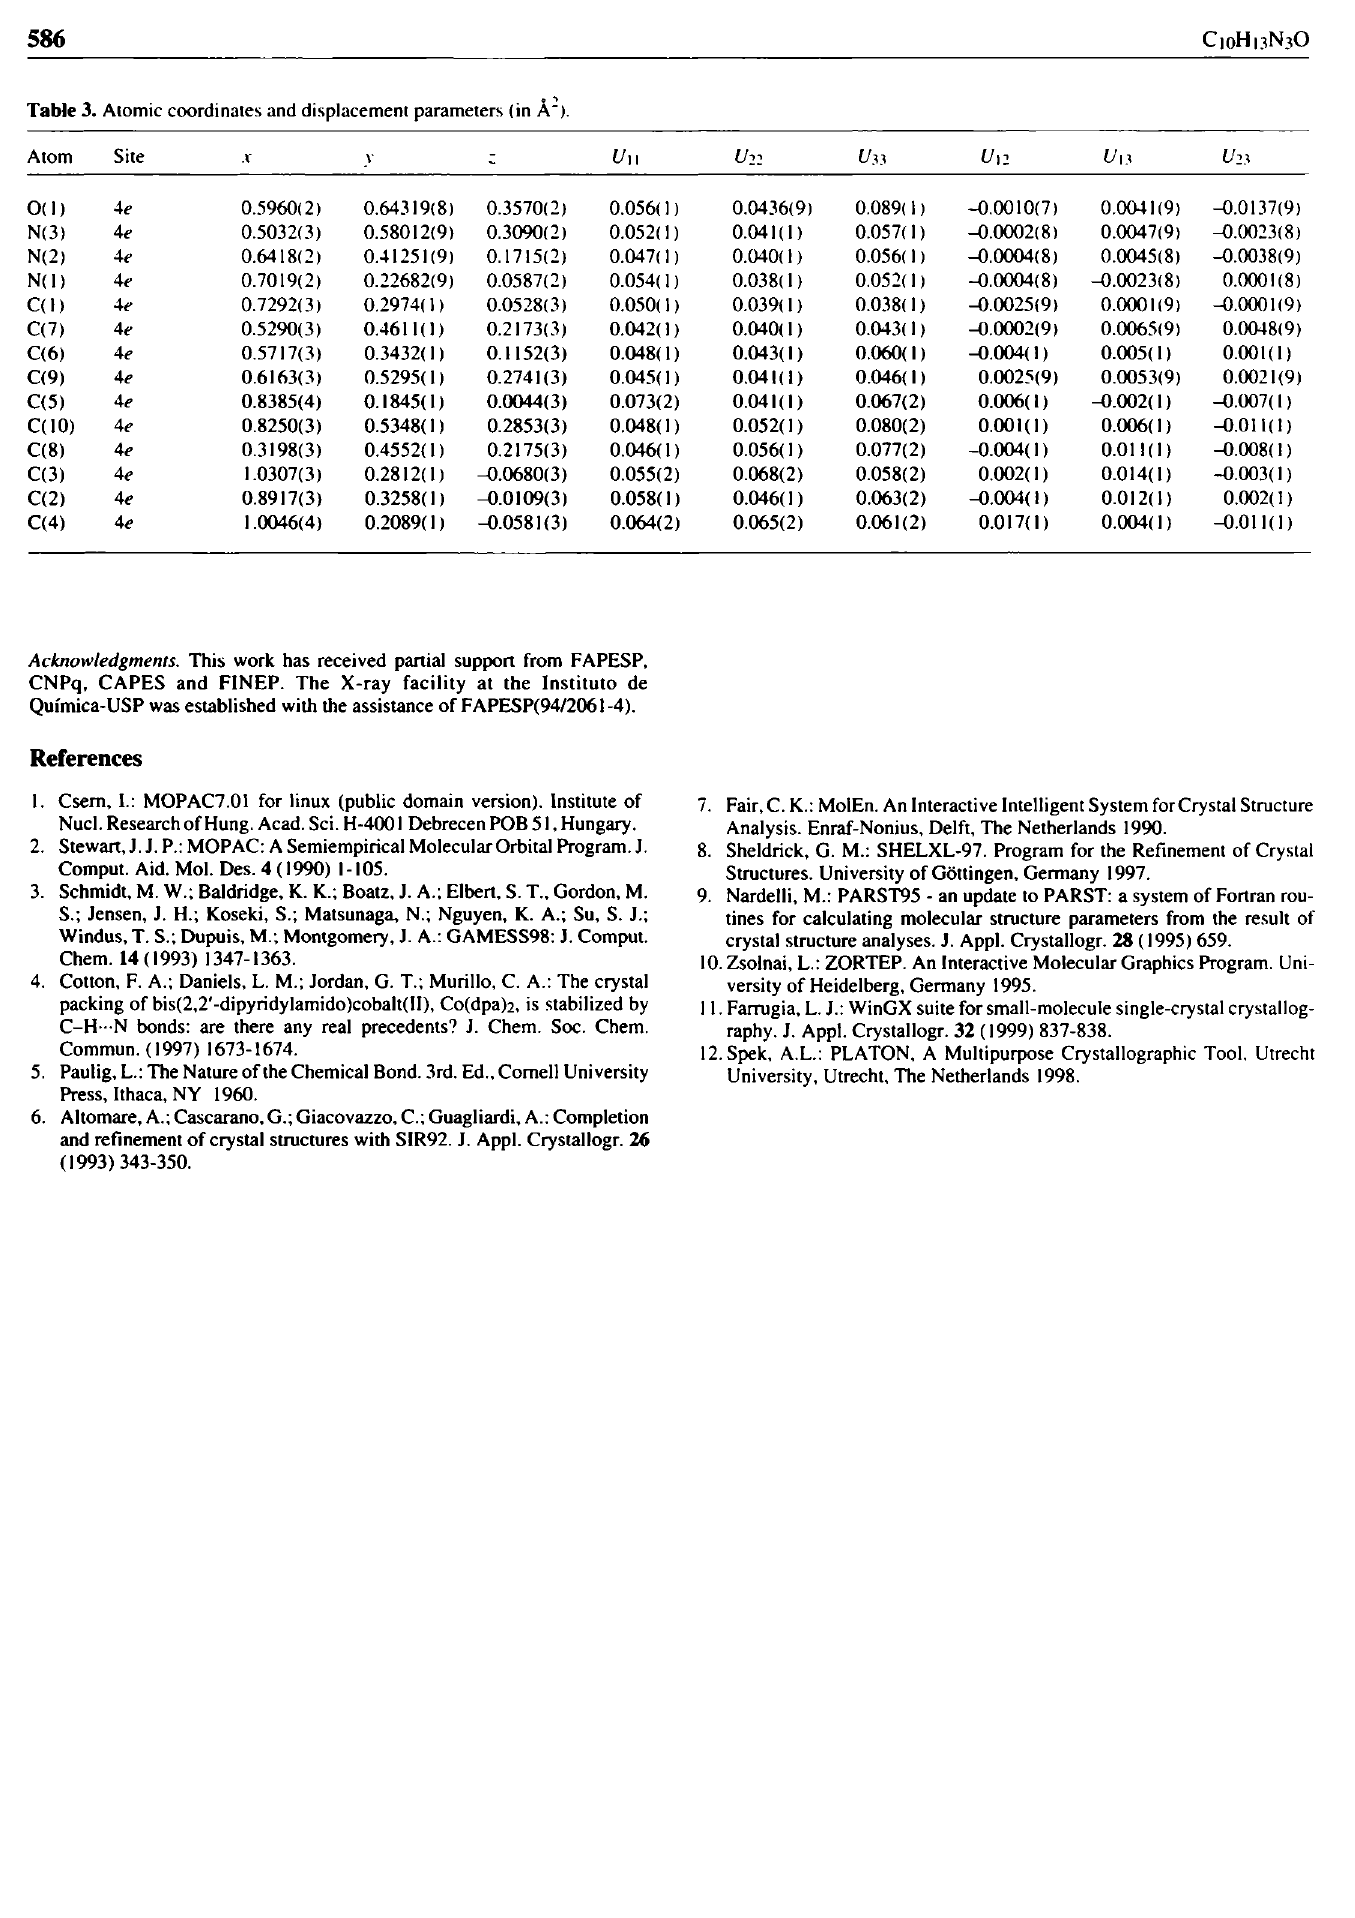
Table 3. Atomic coordinates and displacement parameters (in